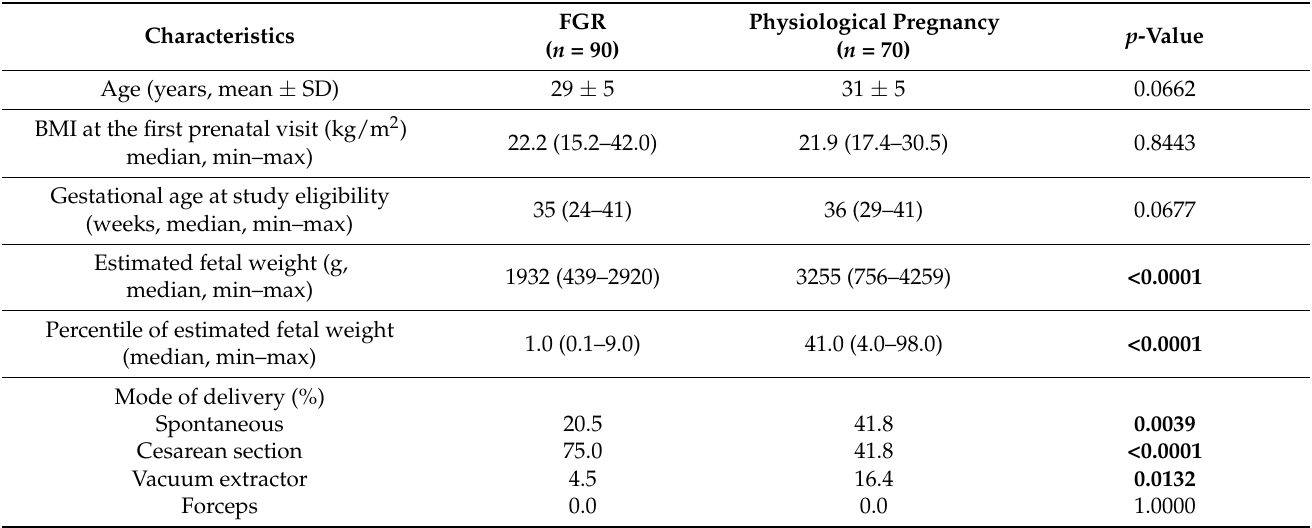
Table 1. The characteristics of the group with fetal growth restriction (FGR) and physiological